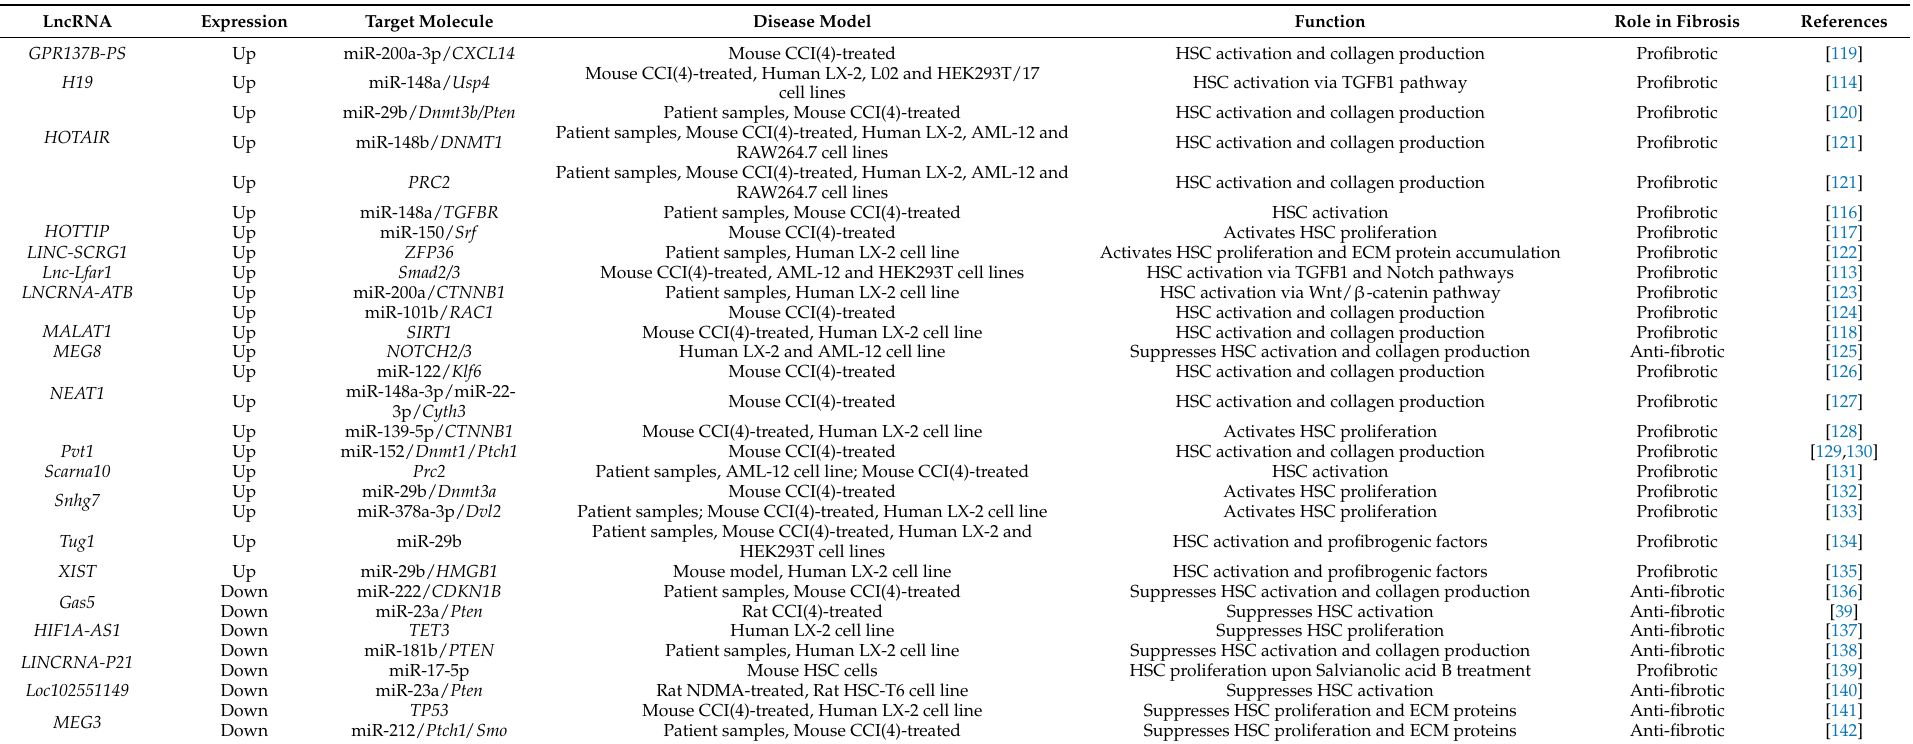
Table 2. Summary of long noncoding RNA (lncRNA) involved in human hepatic stellate cells (HSC) activation in